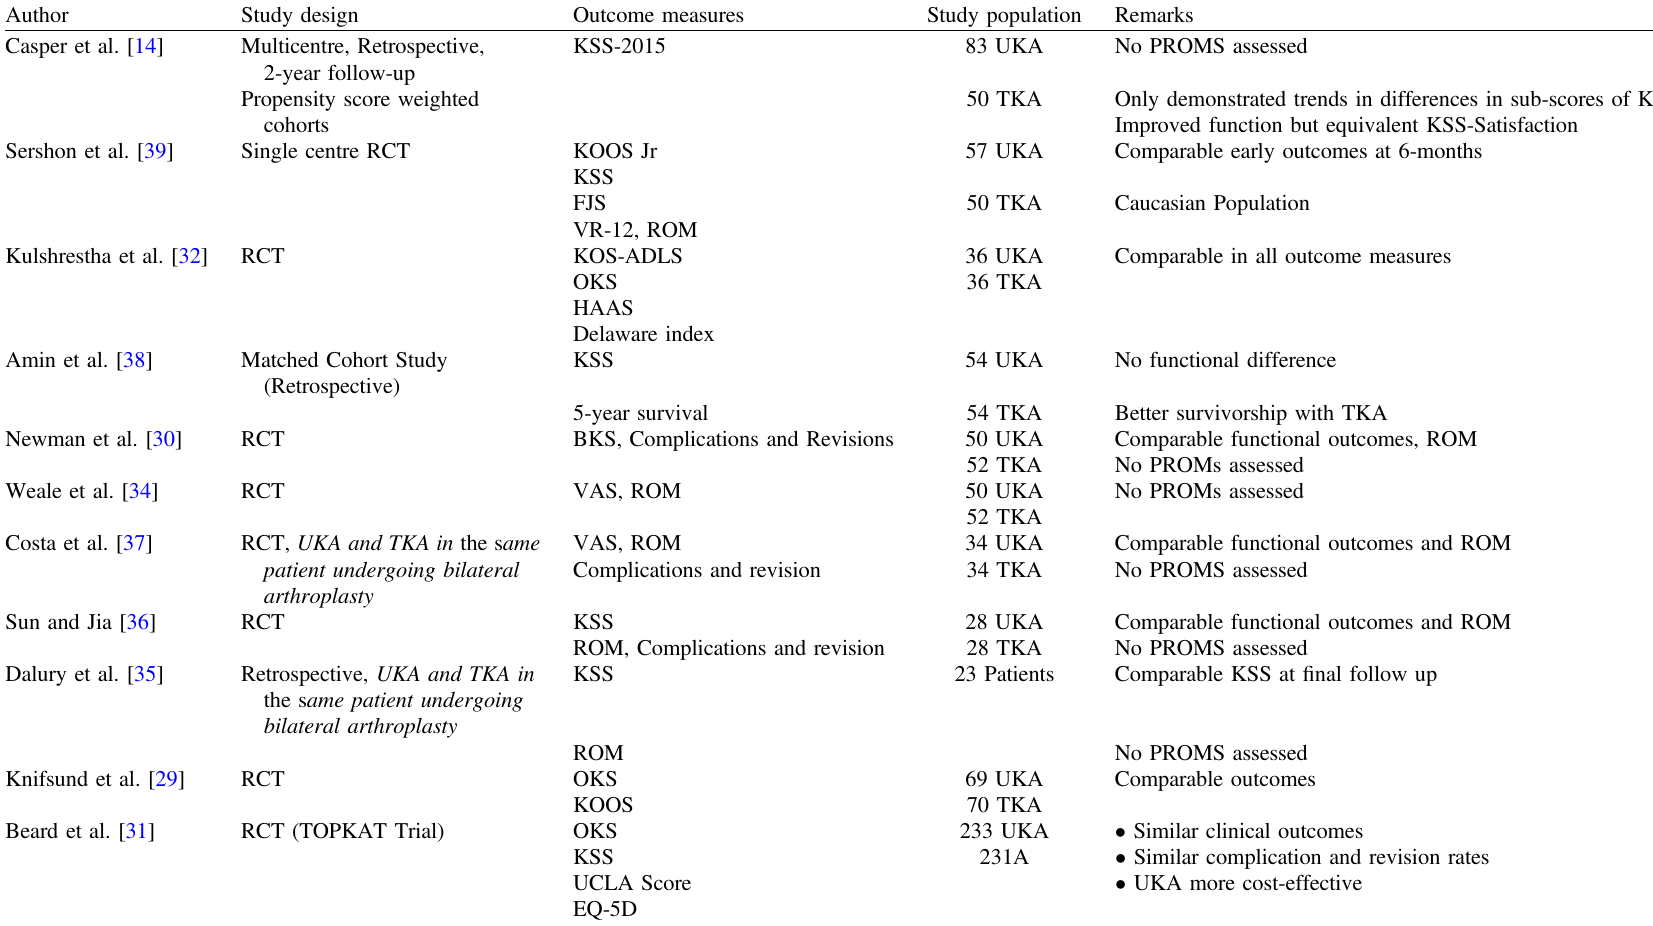
Table 4. Literature published comparing outcomes after UKA versus TKA for isolated medial arthritis of the